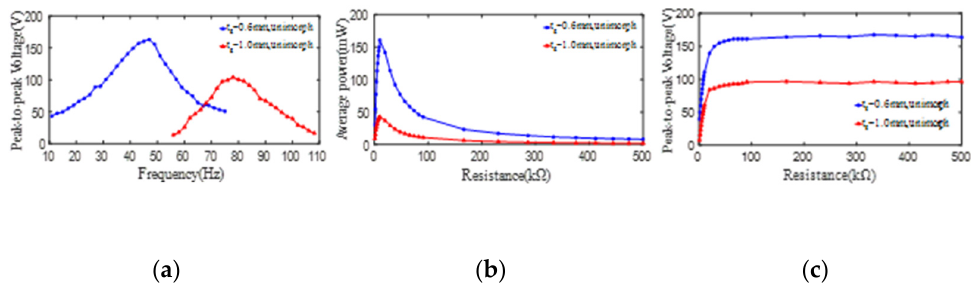
Figure 7. The effect of the substrate thickness on the peak-to-peak voltage and average power of one PZT4 patch bonded on the substrate. ( a ) peak-to-peak voltage versus excitation frequency; ( b ) average power versus load resistance; ( c ) peak-to-peak voltage versus load resistance. In short, with the increase of the substrate thickness from 0.6 mm to 1.0 mm, the However, the 1st natural frequency of the PCD